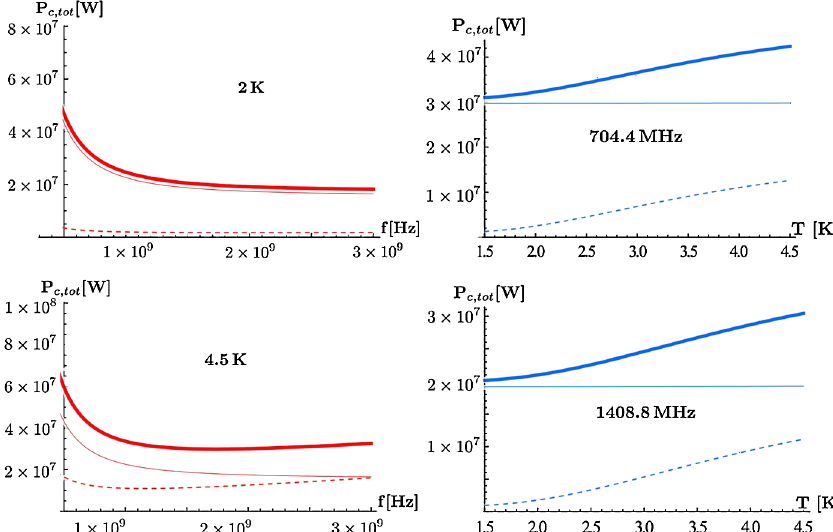
FIG. 7. (Color) Power requirements of the high-power SPL. The left column (red lines) depicts the power consumption as a function of frequency at two bath temperatures, 2.0 and 4.5 K. The right column (blue lines) depicts the power consumption as a function of the bath temperature at two different frequencies, 0.7 and 1.4 GHz. The simulation is performed by applying Eq. (5) and using the parameters for the high- and low-power SPL as indicated in the above boxes at the right. Thick lines indicate the total electrical grid power, thin lines that for the rf system, and dashed lines that for the cryogenic